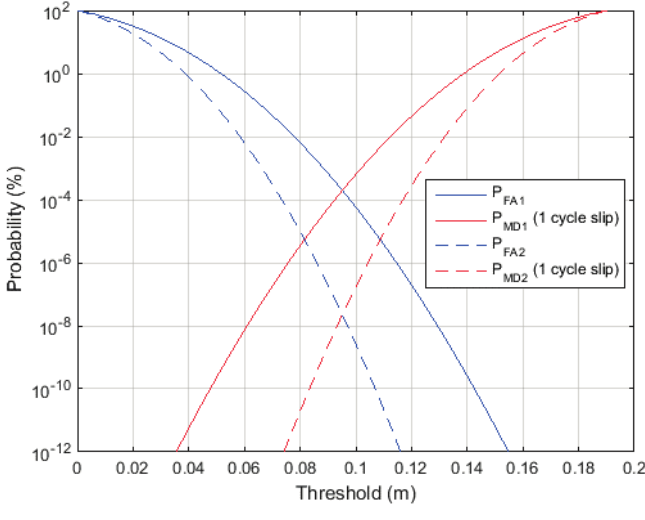
Figure 5. Probability of false alarm and miss